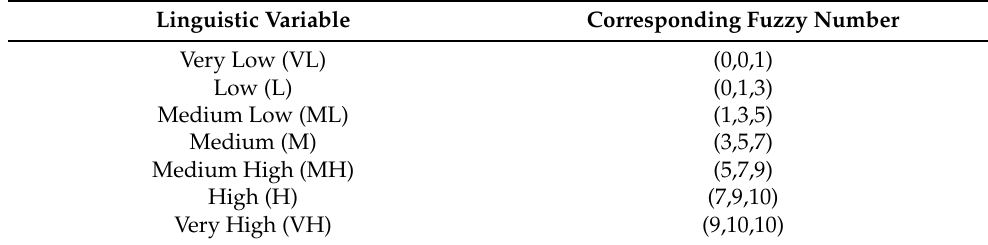
Table 3. Fuzzy numbers for evaluating the